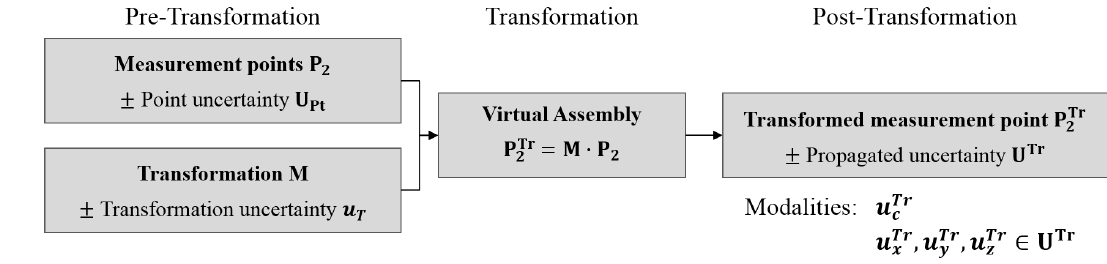
Figure 2. Graphical decomposition of the propagation model.